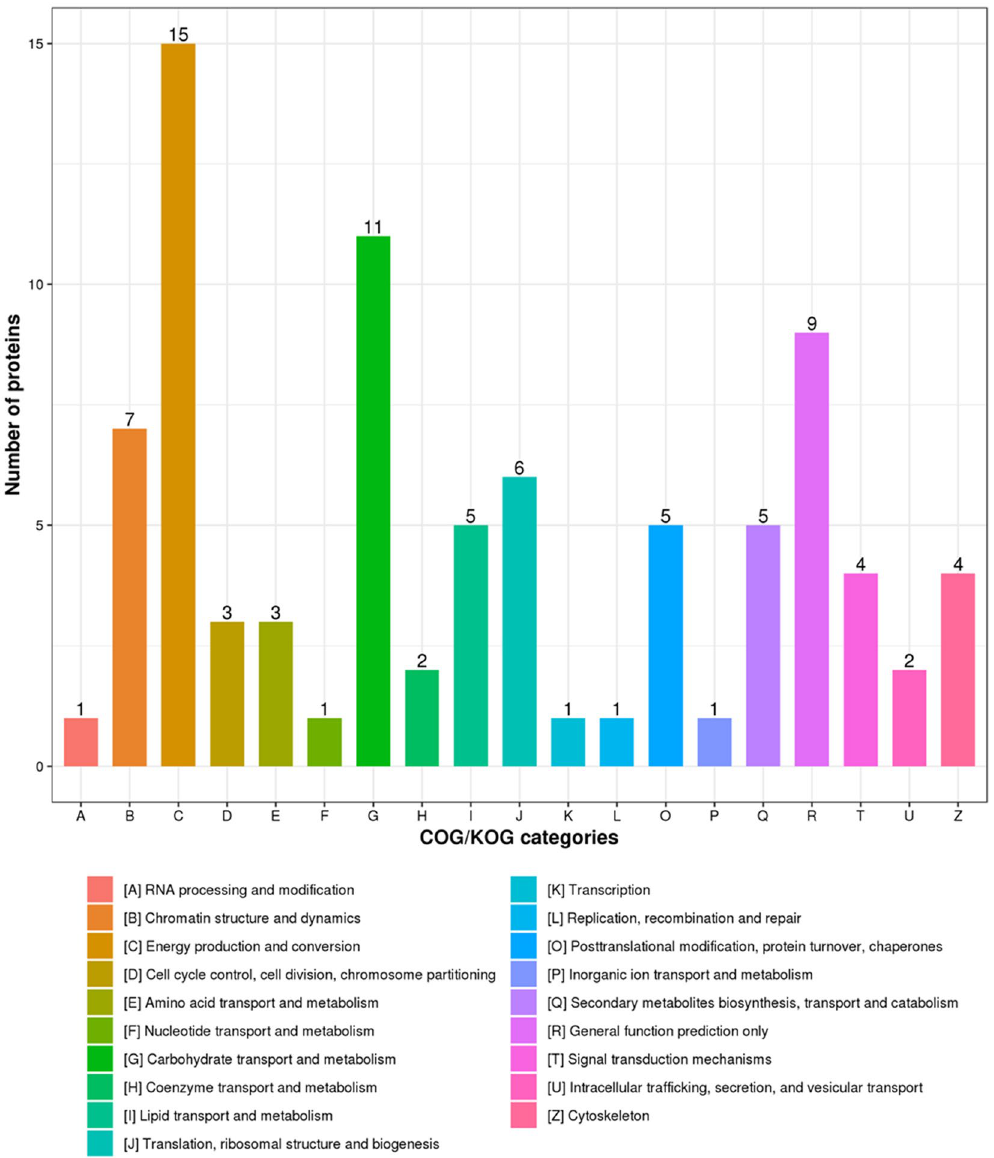
Figure 5. KOG functional classification of differentially regulated Kac proteins in C. chloroleuca